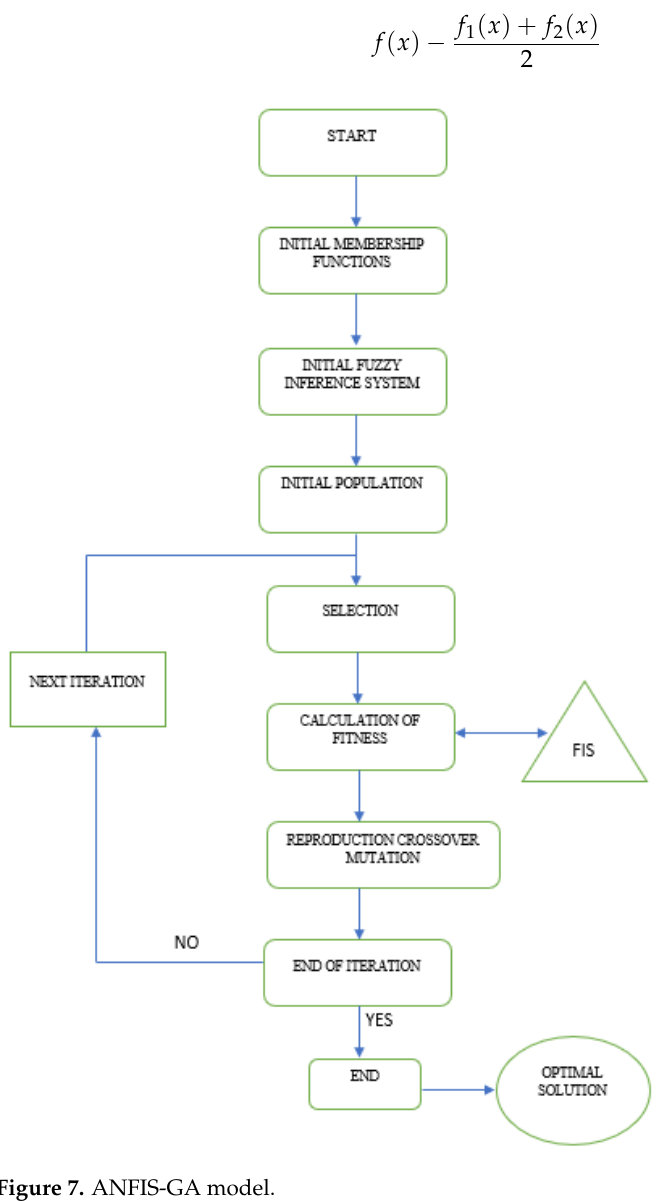
Figure 7. ANFIS-GA model.